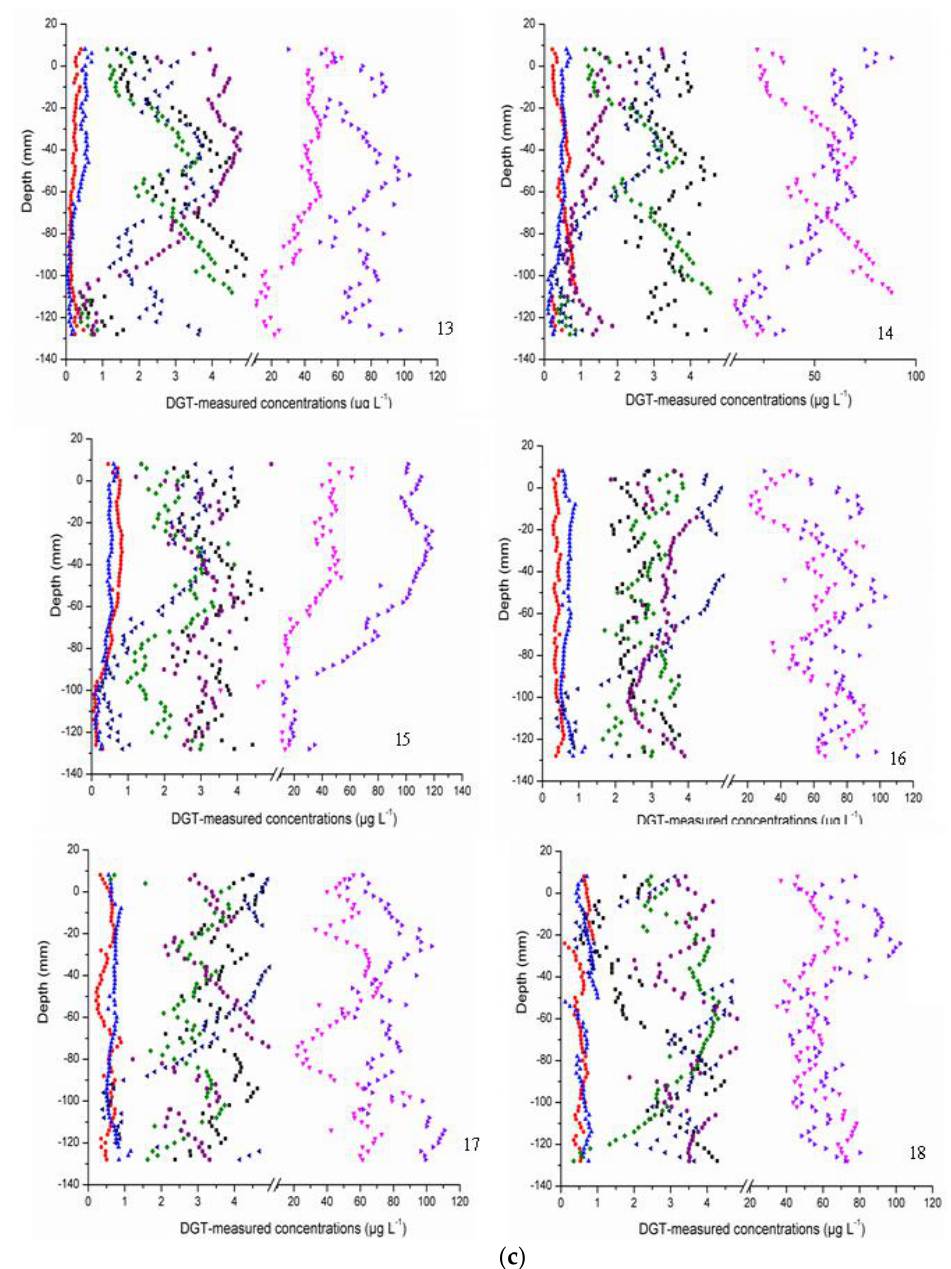
Figure 2. ( a ) The diffusive gradients in the thin films technique (DGT)-measured Cd, Pb, Zn, Fe, Mn, Ca, Mg, and Cu concentrations of sampling sites 1–6 in Lake Hongze. ( b ) The DGT-measured Cd, Pb, Zn, Fe, Mn, Ca, Mg, and Cu concentrations of sampling sites 7–12 in Lake Hongze. ( c ) The DGT-measured Cd, Pb, Zn, Fe, Mn, Ca, Mg, and Cu concentrations of sampling sites 13–18 in Lake